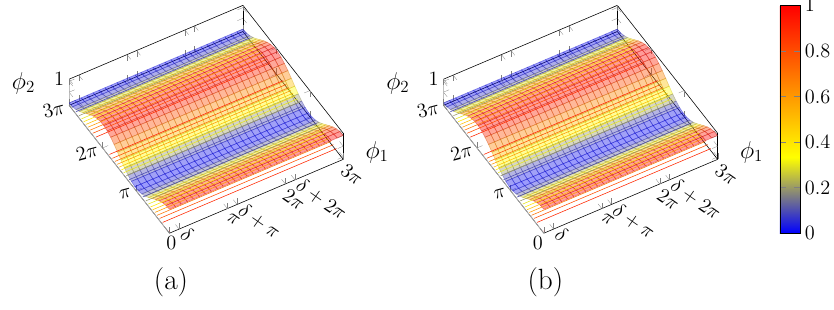
Figure 6. Plot of P L ( φ 1 , φ 2 ) for: ( a ) α = 0; and ( b ) α = π